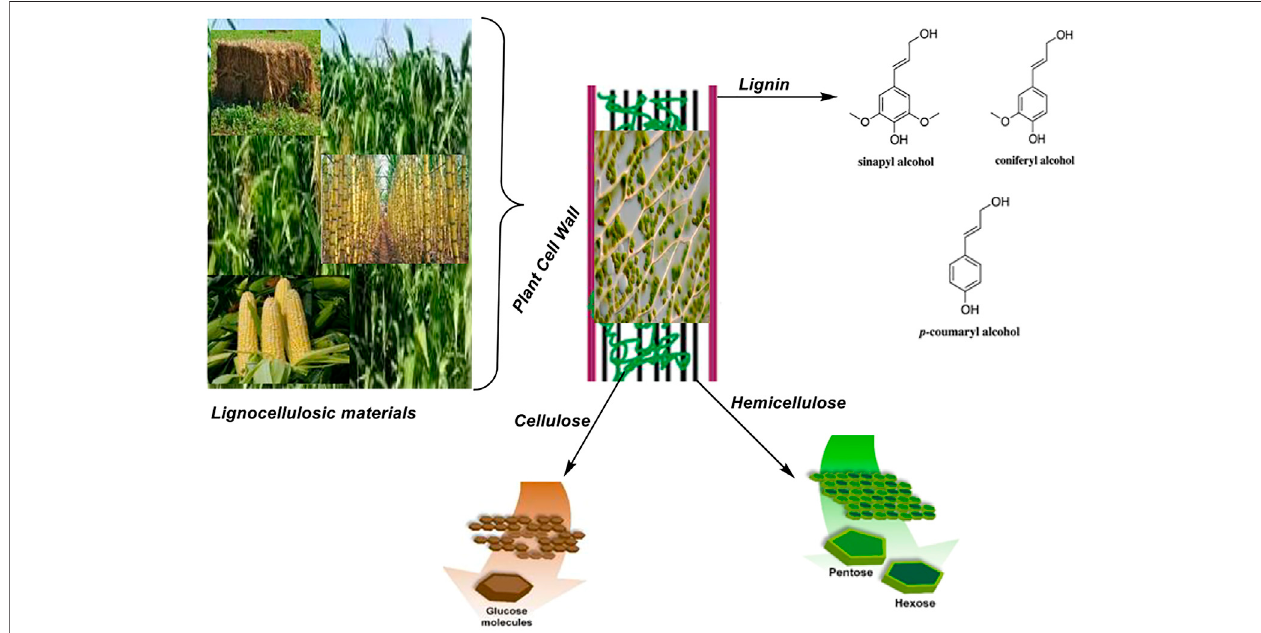
FIGURE 1 | Essential components and structure of